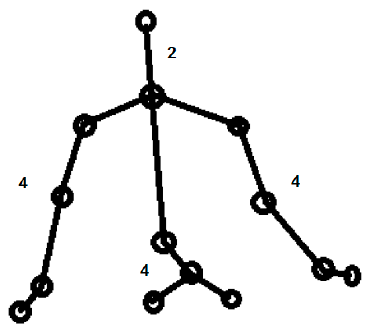
Figure 5. Tracked features for hand and body position and movement.